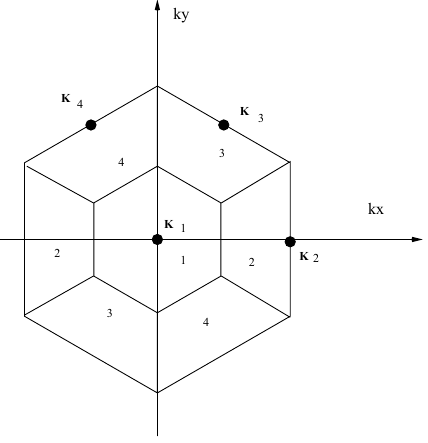
Figure 2. Shows four coarse grain regions of a hexagonal lattice for a four site super cell N c